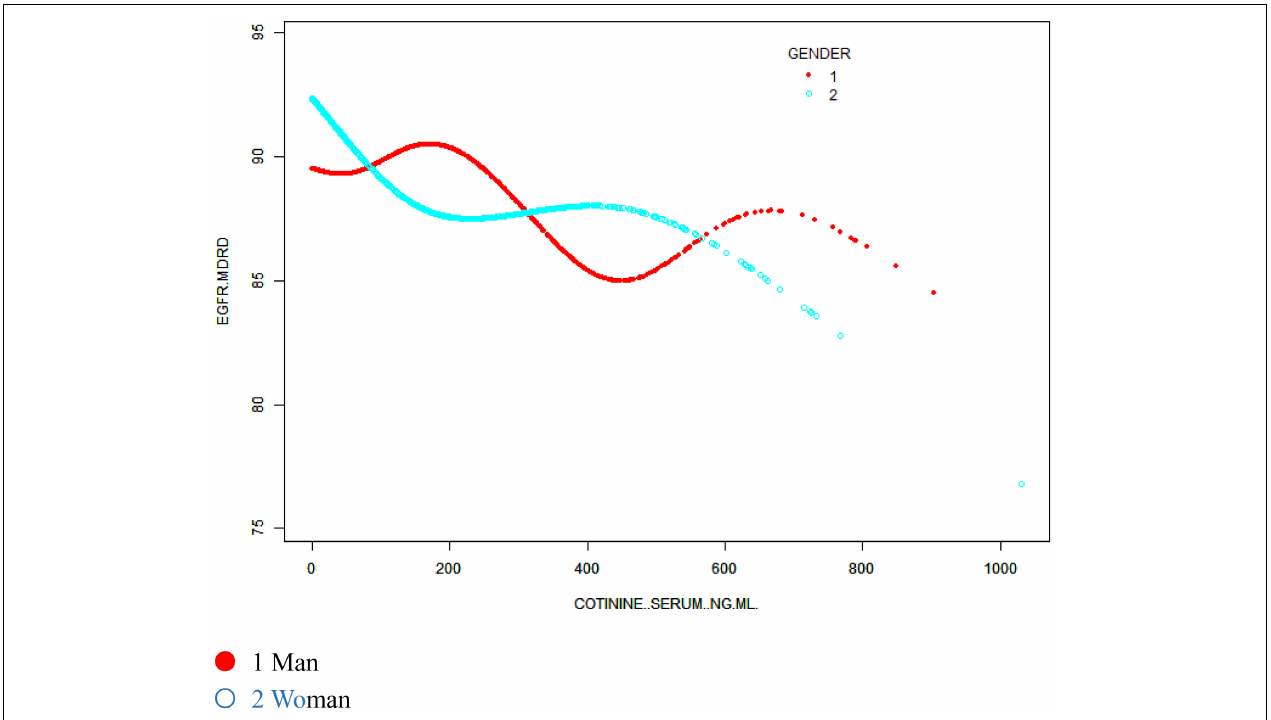
FIGURE 3 | The association between serum cotinine and the eGFR stratified by sex. Age, race/ethnicity, educational background, the ratio of family poverty to income, marital status, BMI, glycosylated hemoglobin, blood glucose, BUN, triglycerides, and uric acid albumin were adjusted.